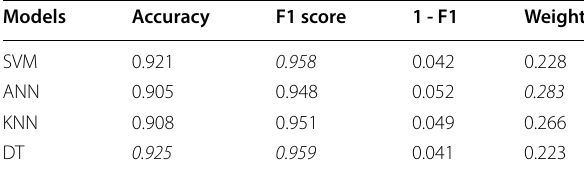
Table 2 Performance and weights for sub-models